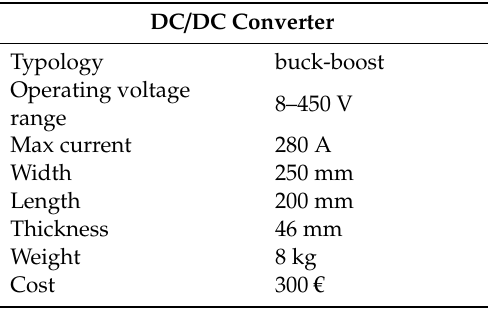
Table 11. Datasheet of DC / DC converter.